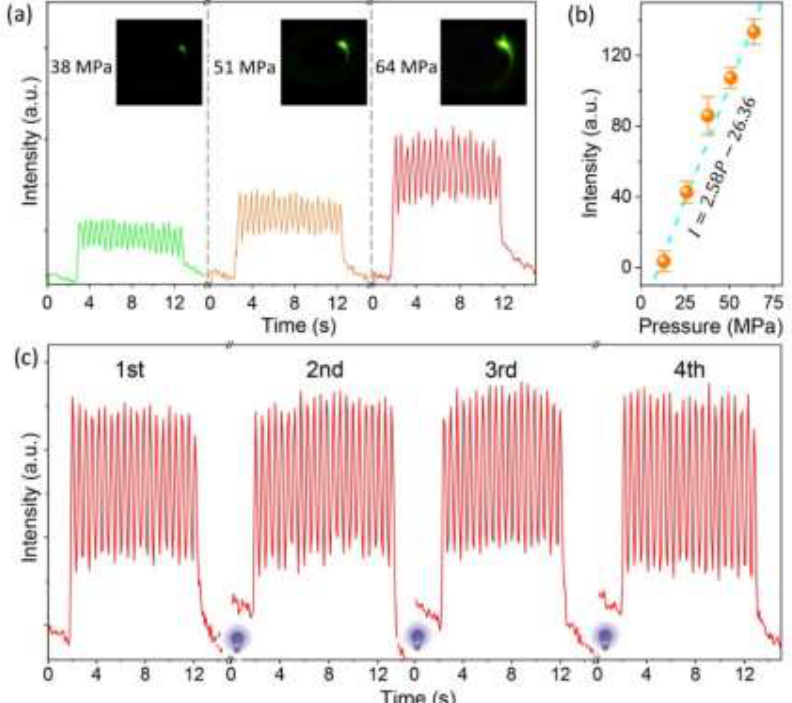
Figure 4. ( a ) Friction-induced ML curves under different pressures, showing a stable ML response during ~20 cycles (4π rad/s). The insets show the instantaneous ML photographs. ( b ) Linear relation between ML intensity and pressure. ( c ) Repeatability and stability test under cyclic friction (64 MPa, 4π rad/s) and UV irradiation (254 nm, 1 min).